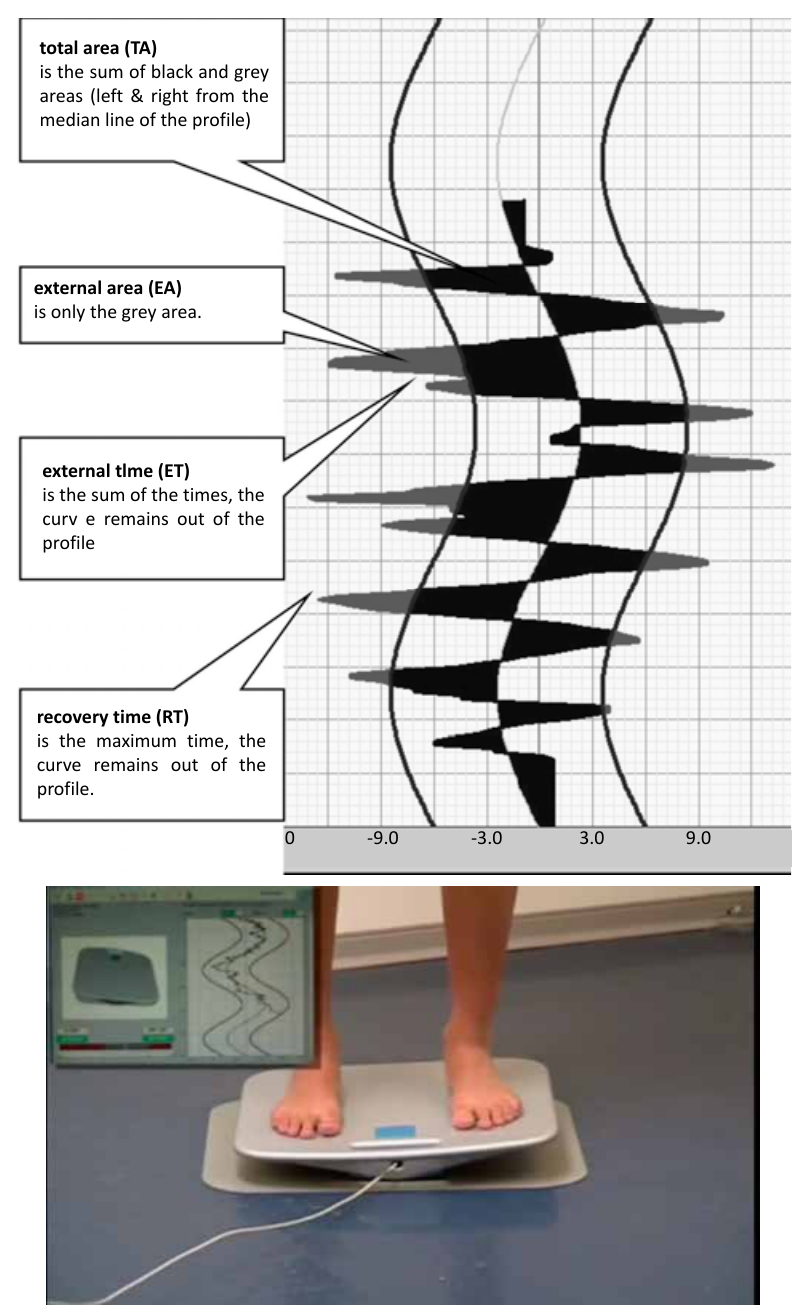
Figure 2. Libra See Saw Balancing Board.